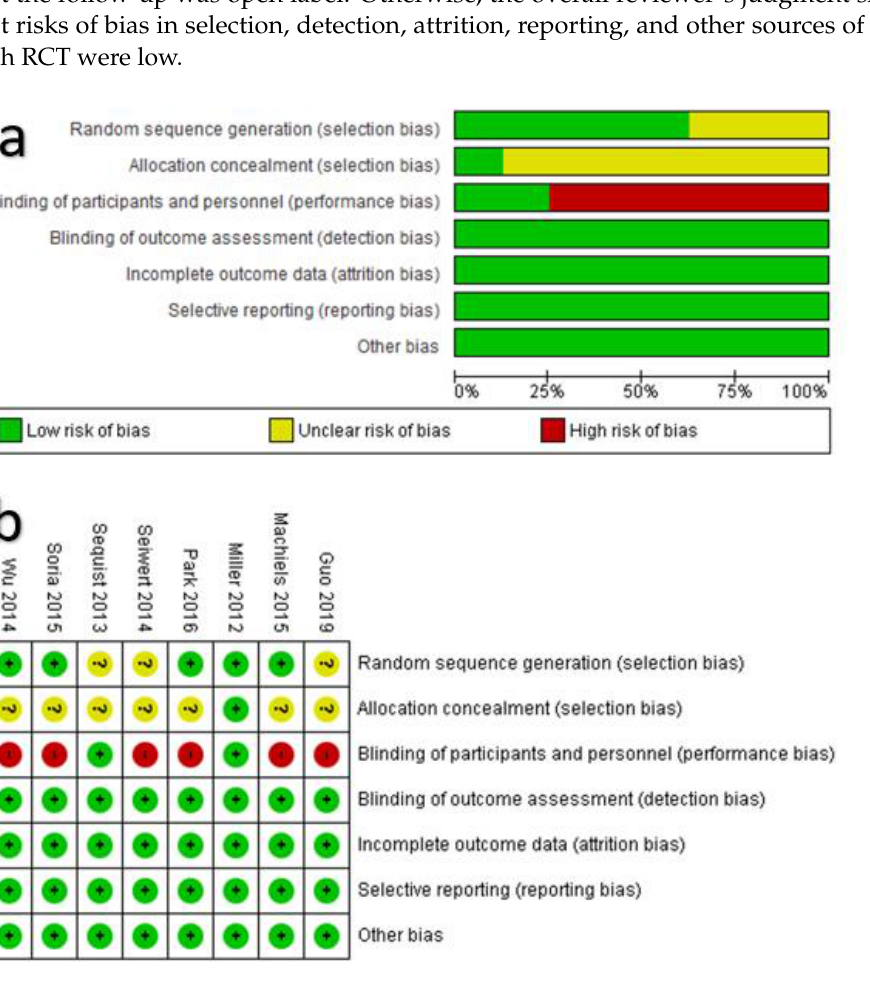
Figure 2. Appraisal of the risk of bias in the included randomized controlled trials (RCTs). ( a ) Total bias risk in all RCTs, ( b ) summary of bias risk in individual RCTs.